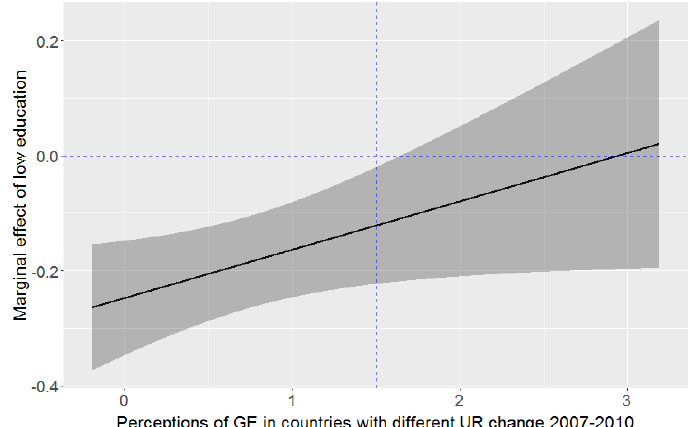
Figure 4 . Effect of gender upon perceptions of gender equality in countries with different UR change 2007- 2010.